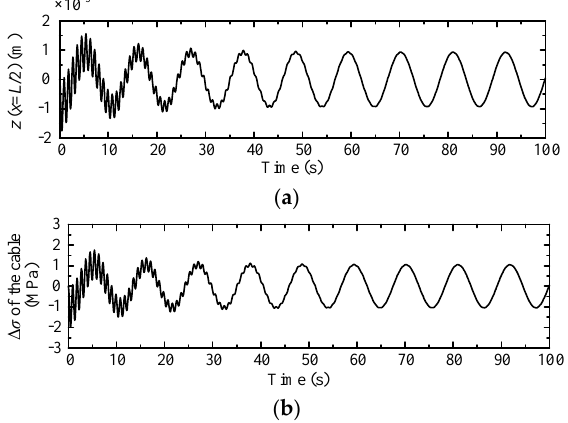
Figure 6. Response of SFT components under the single effect of wave force: ( a ) displacement in the mid-span of tube; ( b ) cable stress variation.